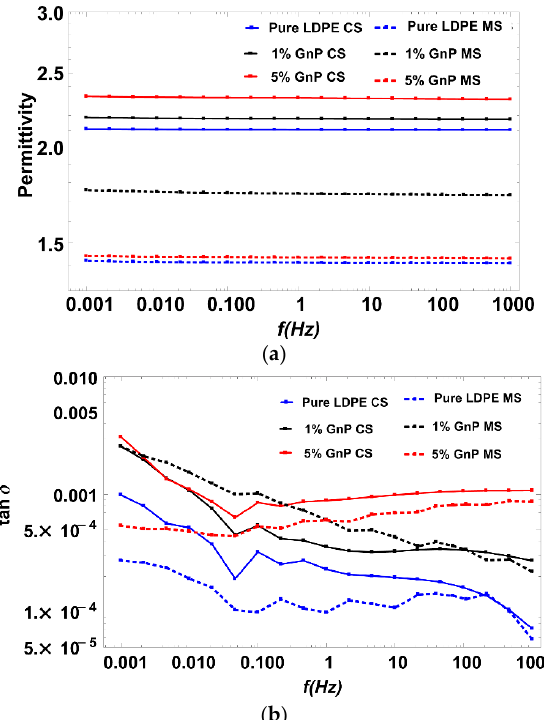
Figure 9. Dielectric response of CS vs. MS ( a ) dielectric constant and ( b ) dielectric loss.